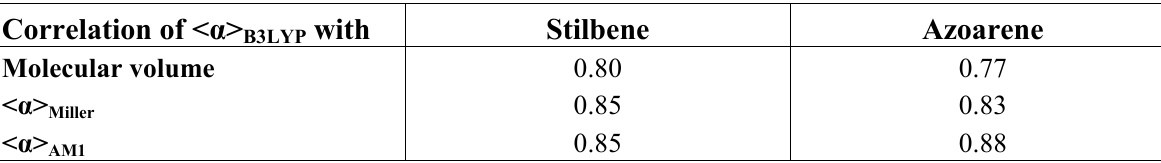
Table 11. Linear regression coefficients r for the Stilbene/ azoarene series II and